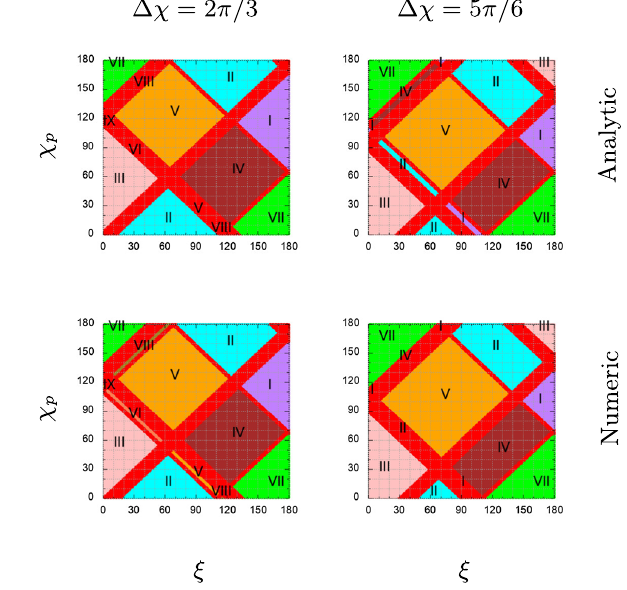
Fig. 19 Classlocationmapsonthe ξ − χ p plane.Schwazschildmetric, (cid:11) = 0 . 0